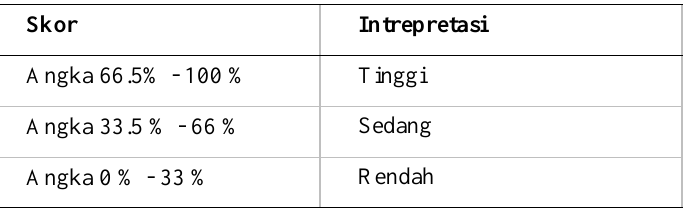
Tabel 1. Tabel Kategori Intrepretasi Skor